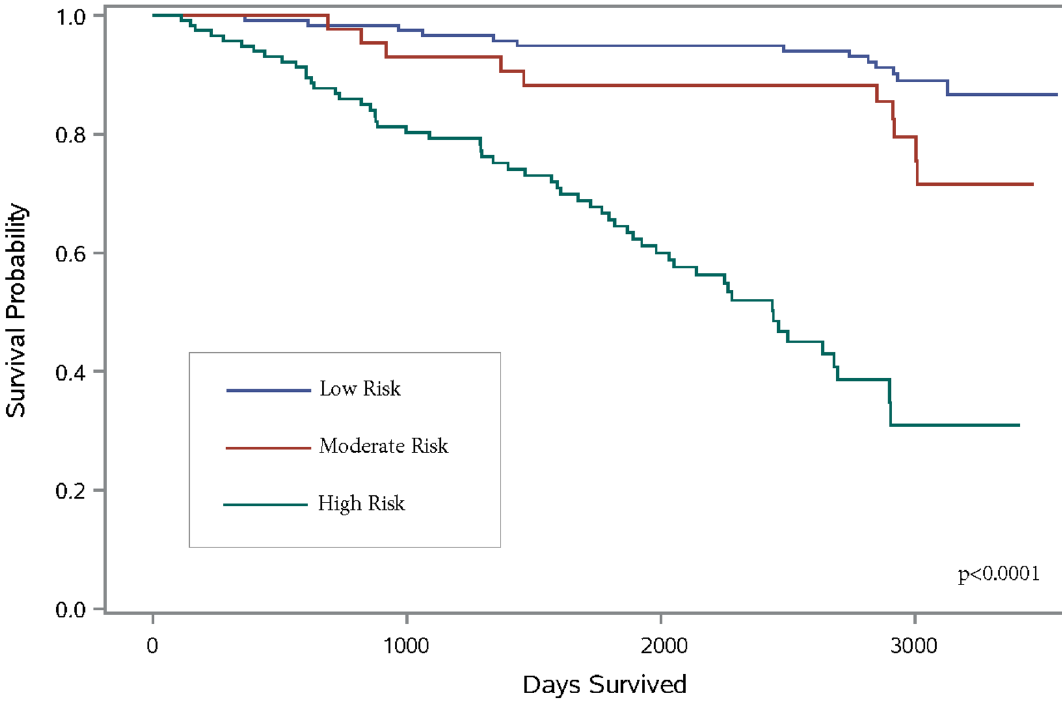
Figure 3. Kaplan Meier survival curves for 10-year cardiovascular mortality stratified by each risk cluster. The following scores were used to derive the risk clusters: SHFM (Seattle Heart Failure Model), FRS (Framingham Risk Score), MAGGIC (Meta-analysis Global Group in Chronic Heart Failure), BCN Bio-HF (Barcelona Bio-Heart Failure Risk Calculator), and Cardiac Lipid Panel Risk Score (CLP). Each prognostic score was standardized to the same scale (mean = 0; SD = 1). Total subjects, n = 280; total events, n =